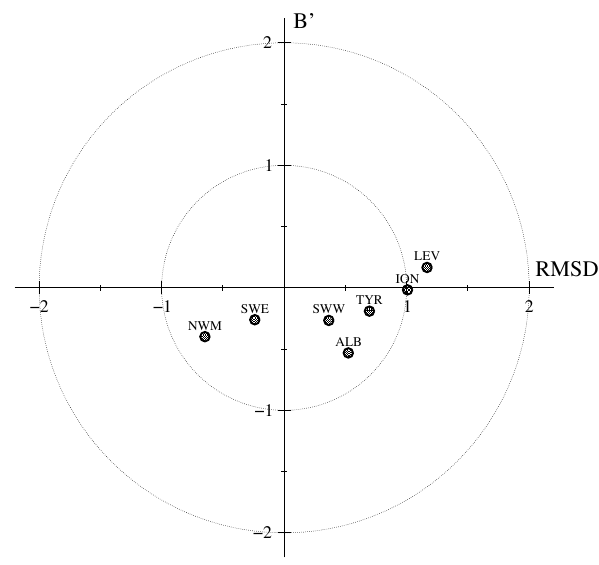
Fig. 7. Target diagram comparing model-derived seasonal cycle in surface chlorophyll concentrations with those derived from SeaW- IFs for the different regions defined in Fig. 1. Each dot is the median of the temporal skill of each pixel for the specific regions described in Fig.